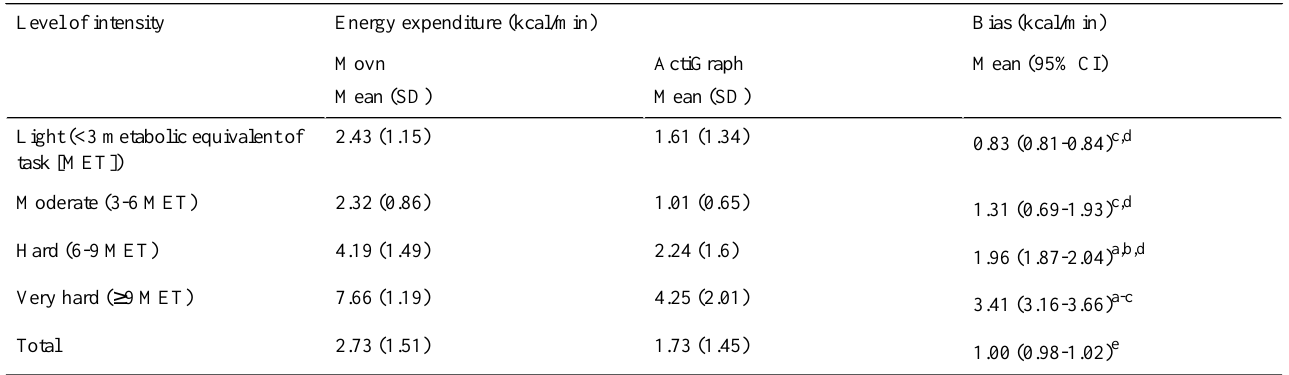
Table 4. Energy expenditure during phase 1 free-living activities.